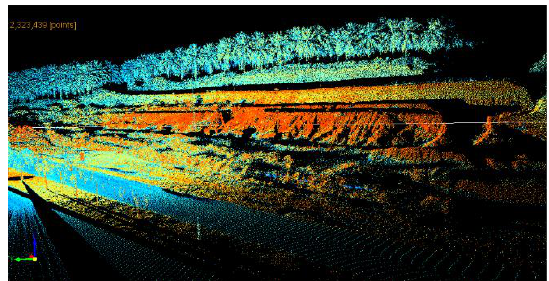
Figure 29. Data after registration was oriented and aligned from multiple scan positions